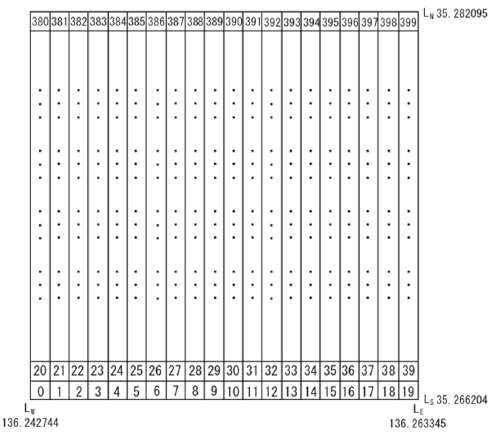
Figure A1. Geographical meshes with node numbers for the Hikone sightseeing area used in this study. Size of one grid or one mesh unit is 88.4 by 93.6 m. L N (35.282095 deg.), L S (35.266204 deg.), L E (136.263345 deg.), and L W (136.242744 deg.) indicate area boundary lines defined by corresponding degrees in longitude and latitude. Table A1. List of identical numbers for nodes visited by a rickshaw at least once. Sequence on Axes in Number in Figure A1 Sequence on Axes in Number in Figure A1 Figure 9 and in Axes of Figure 9 Figure 9 and in Axes of Figure